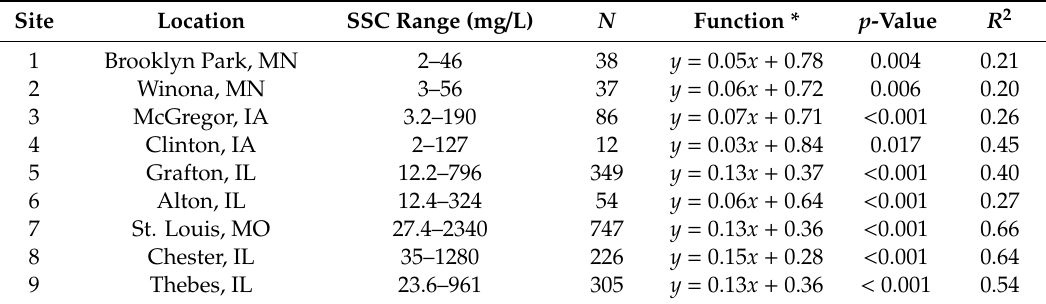
Table 5. Gauge-specific functions developed for SSC estimation.